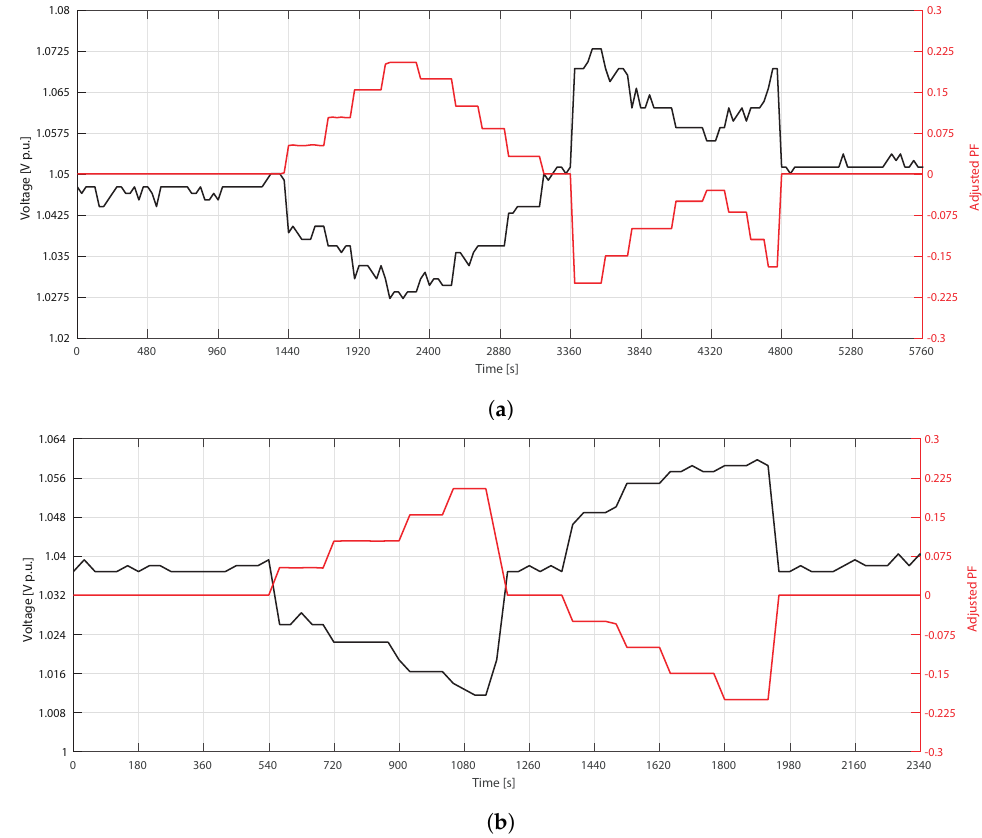
Figure 3. Physical microgrid relations between power factor variations (input) and voltage (out- put) on B11_ADM PV system. ( a ) Model identification experimental dataset; ( b ) Model validation experimental